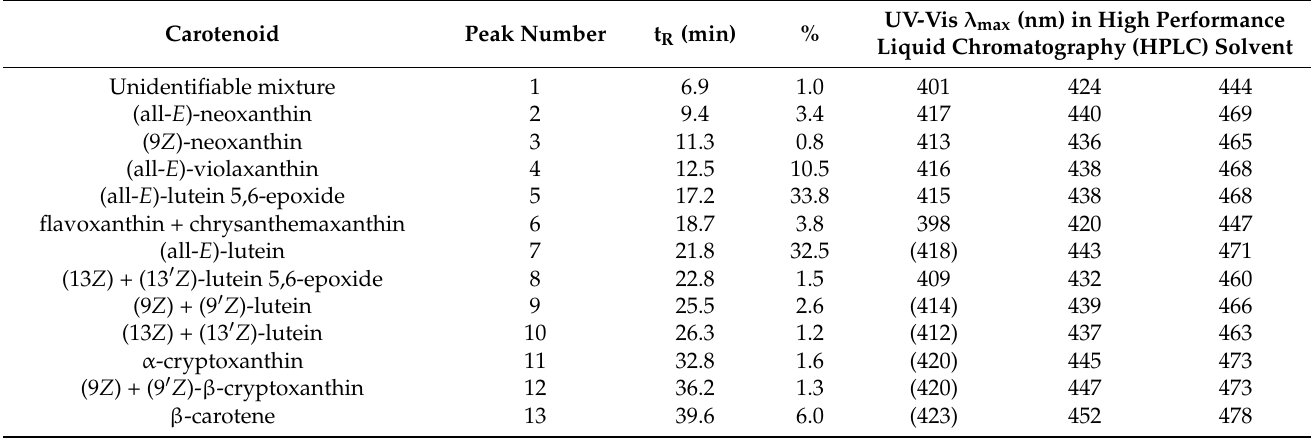
Figure 1. The HPLC chromatogram of the total extract of Meliloti herba. Detection at 450 nm; other conditions in the Material and Methods section. For peak numbers see Table 1. Table 1. The carotenoid composition of the total extract of Meliloti